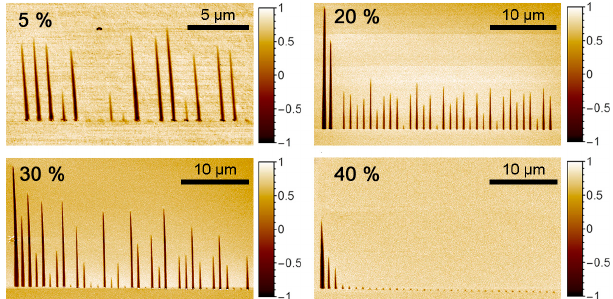
Figure 1. Piezoelectric force microscopy (PFM) images of the domain series produced by the local polarization reversal on the Y-cut of MgOLN at different relative humidities. Spacing between the points of bias application was 1 µm, and the pulse amplitude was 100 V.